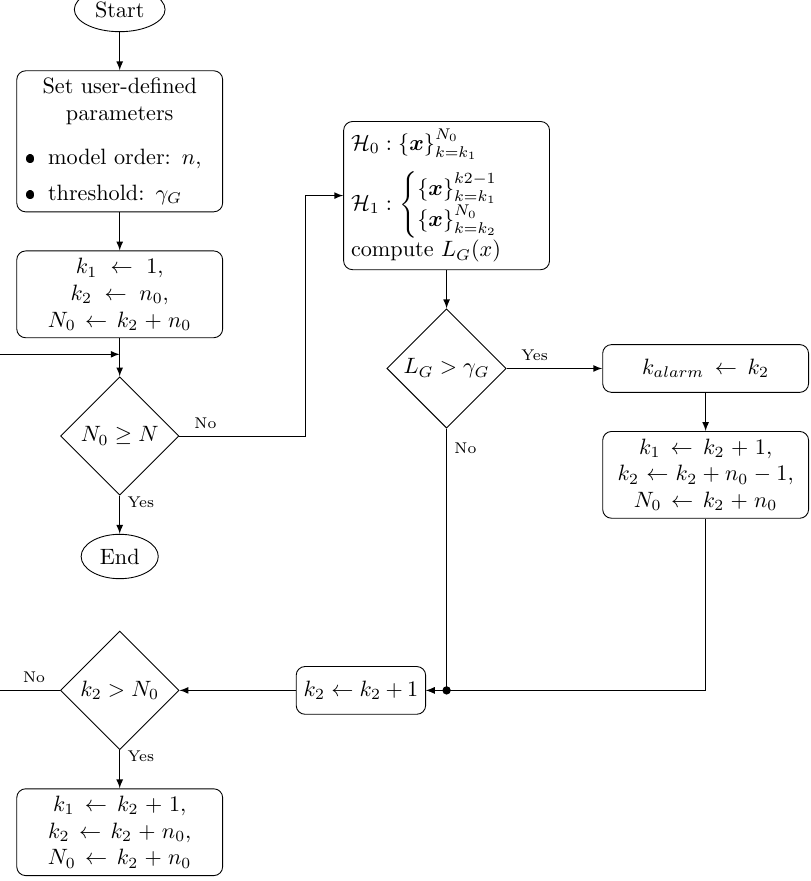
Figure 4. Flow diagram of the statistical AD method based on the GLRT